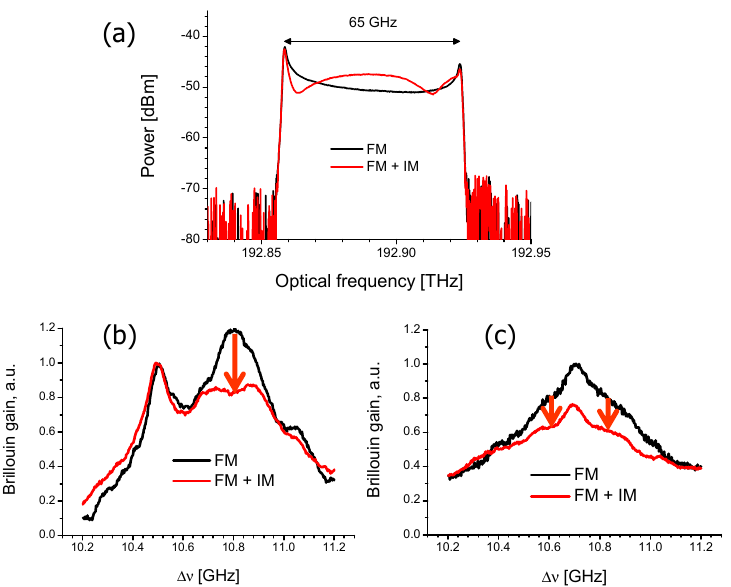
Figure 24. Experimental results of the IM scheme [51]. ( a ) Time-averaged laser diode (LD) power spectrum shapes without (black) and with (red) the IM modulation. The appropriate IM waveform is used. ( b , c ) BOCDA output spectra for the cases with (red) and without (black) the IM modulation; ( b , c ) correspond to the measurement at a strained portion and a non-strained portion along the fiber, respectively.